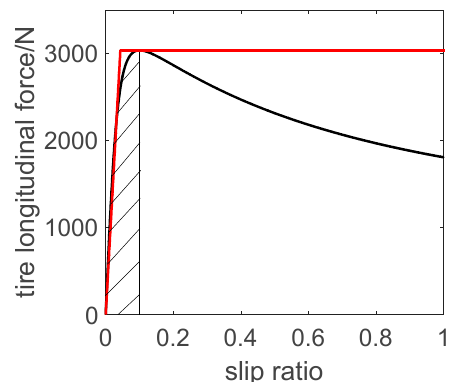
Figure 2. Simplified tire adhesion curve.